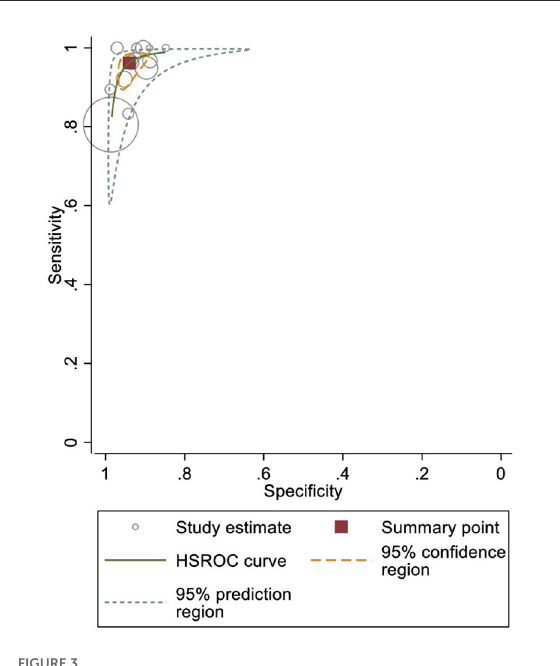
FIGURE3 Sensitivity and specificity of office blood pressure (BP) devices to detect atrial fibrillation (AF).